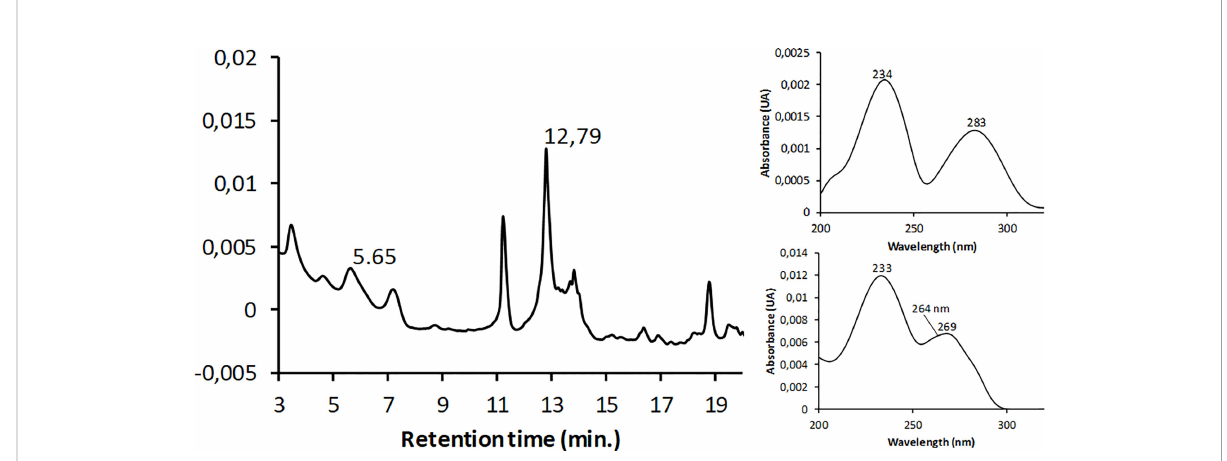
FIGURE 6 Methanolic-water soluble extract of P. borbonicum . LC-DAD chromatogram monitored at 233 nm (left). Peaks at retention time 5.65 and 12.79 min correspond to borbotoxin A/B and 42OH-PLTX respectively. UV spectrum between 200 and 325 nm (right) at 5.65 min (at top) and 12.79 min (at